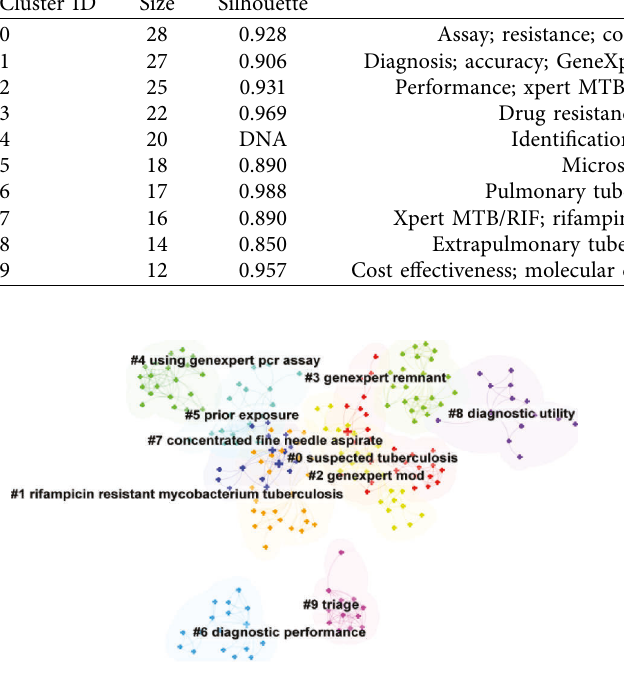
Figure 9: Grouping of keywords for GeneXpert in tuberculosis.